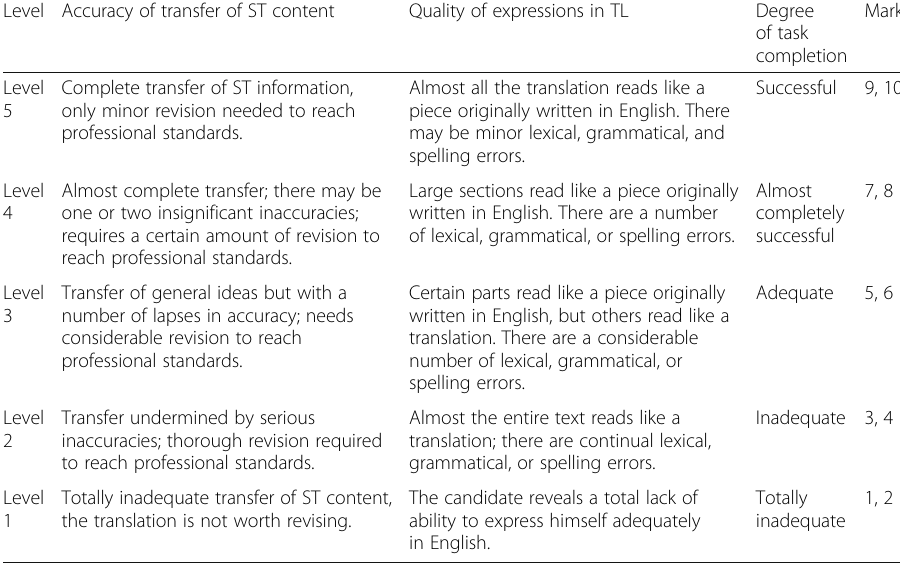
Level Accuracy of transfer of ST